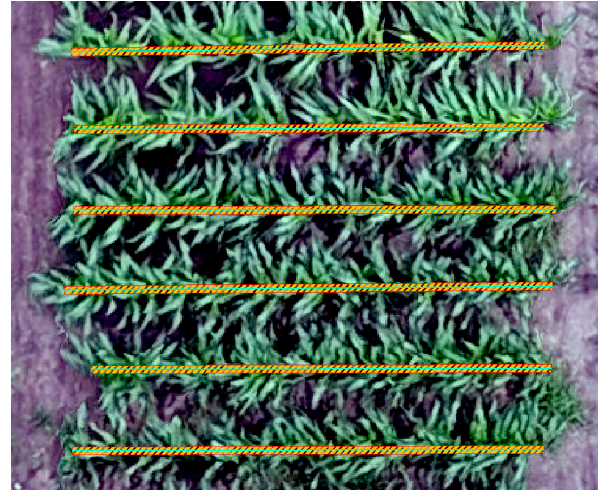
Figure 4. Height calculation based on polygons painted with stripes along the row centerlines (polygon width: 10 cm).